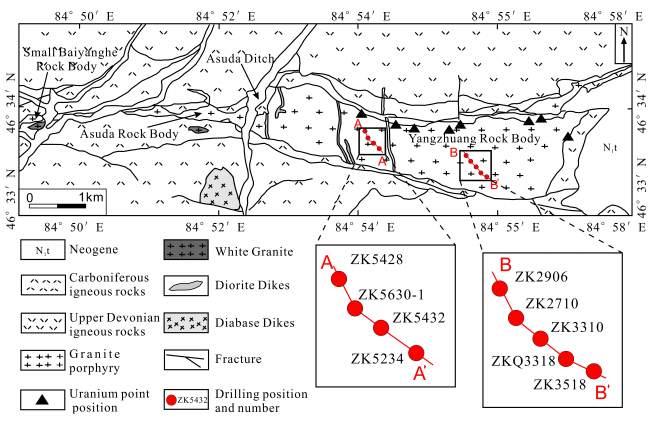
Figure 2. Geological map of the Baiyanghe uranium deposit and drilling locations (modified from [22,24]).